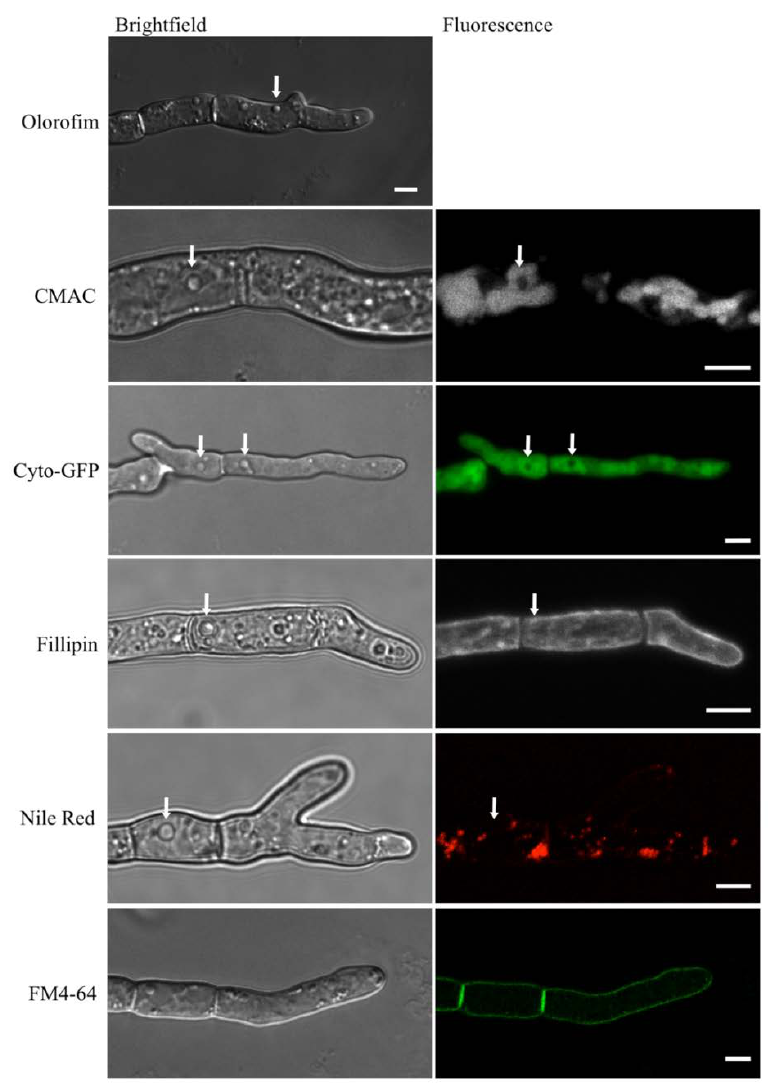
Figure 8. Unidentified, vesicle-like structures were detected in olorofim-treated hyphae. They are readily identified in unstained DIC images (arrow) but are not stained with CMAC, Filipin, negative staining with cytosolic GFP (cyto-GFP), Nile Red (arrows) or FM4-64. Scale bar = 5 µm.